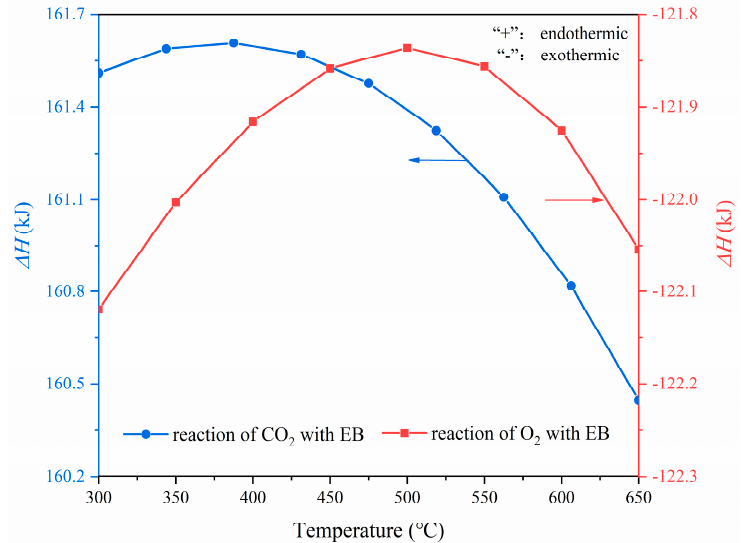
Figure 1. Enthalpy change of the reaction of CO 2 or O 2 with ethylbenzene ODH at different temperature conditions obtained by HSC software simulation.